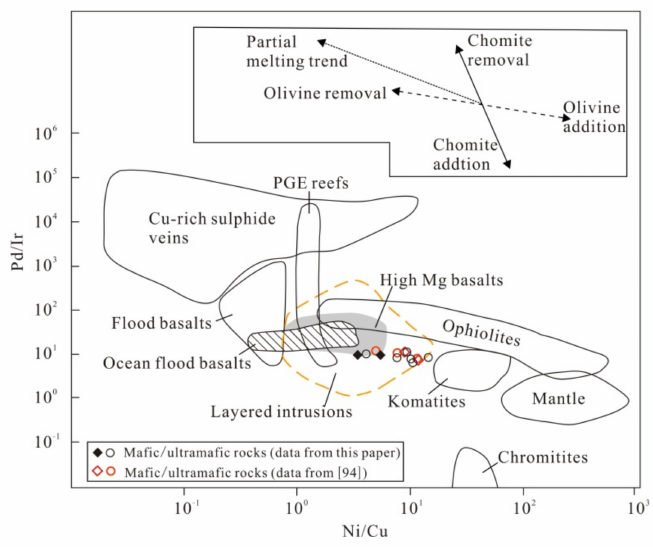
Figure 10. Ni/Cu-Pd/Ir diagram of the rocks from the Baixintan intrusion (after [93]). Data are from this paper and